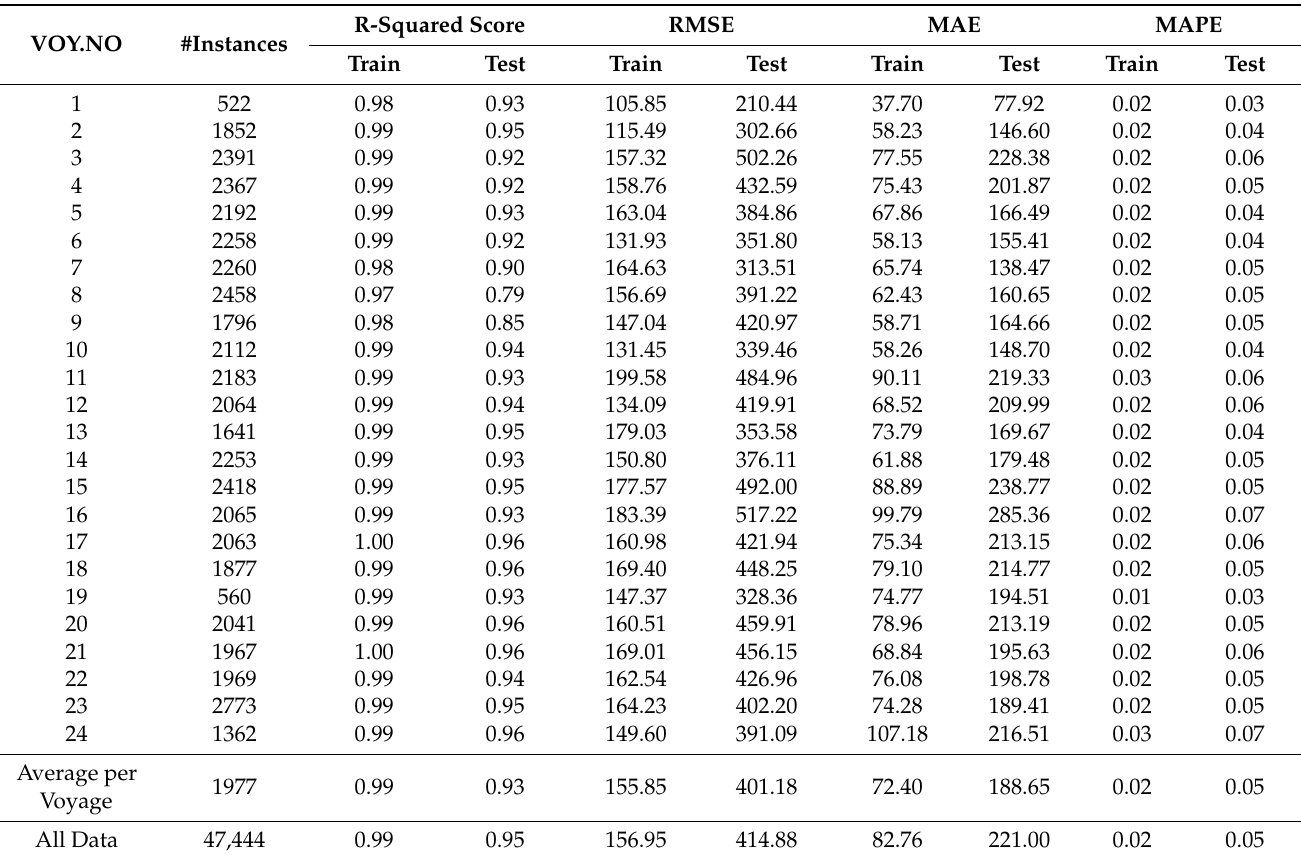
Table 9. Performance metrics per voyage